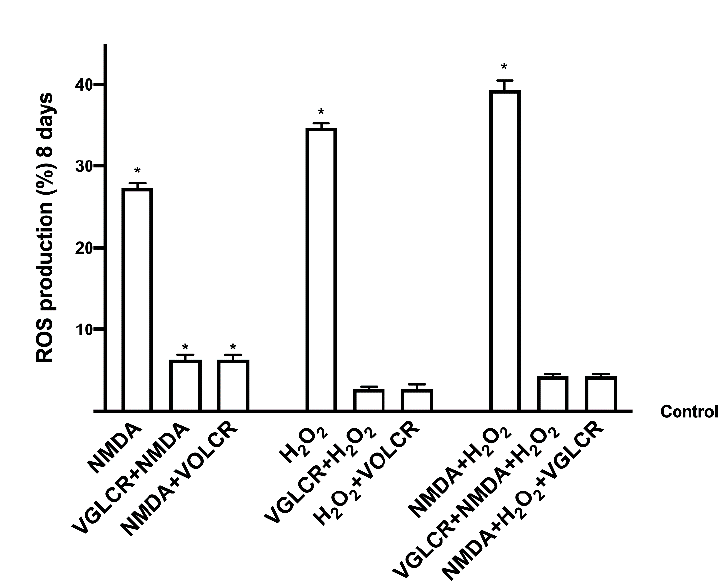
Figure 2. Cell viability and ROS production of RGC cells treated with NMDA and H 2 O 2 . In ( A ), cell viability is measured after NMDA and H 2 O 2 alone and together, before and after VGLCR stimulation. Results are expressed as means ± SD (%) vs. control (0% line) of 4 independent experiments, each performed in triplicate. a–i p < 0.05 vs. control; b and c p < 0.05 vs. a; c p < 0.05 vs. b; e and f p < 0.05 vs. d; i and h p < 0.05 vs. g; I p < 0.05 vs. h. In ( B ), the same stimulation used on panel ( A ) to analyze ROS production. Results are expressed as means ± SD (%) vs. control (0% line) of 4 independent experiments each performed in triplicate. * p < 0.05 vs. control. Abbreviations are the same as used in Figure 1.